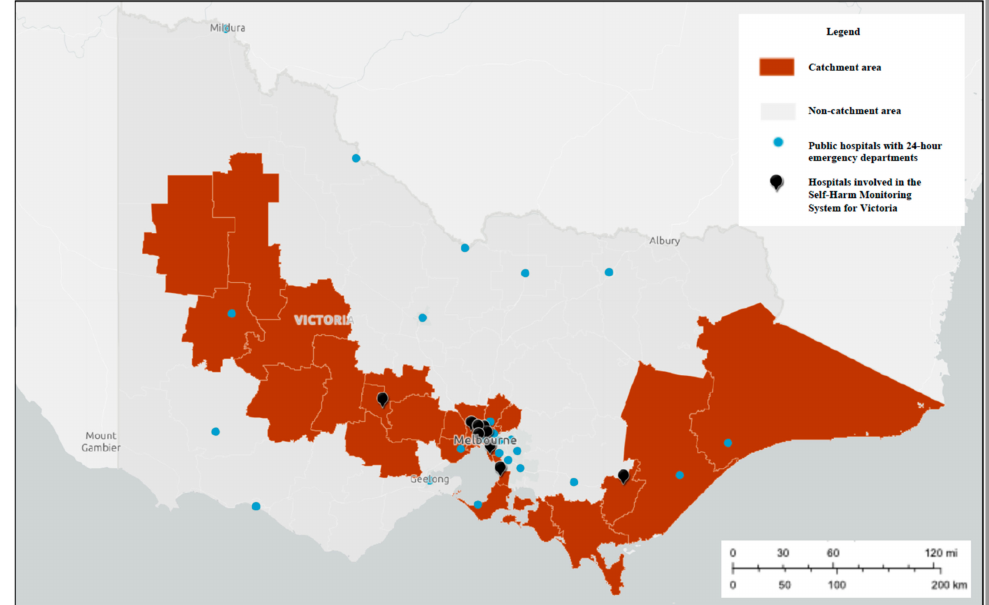
Figure 1. Geographical location of eight emergency departments (EDs) currently participating in the Self-Harm Monitoring System for